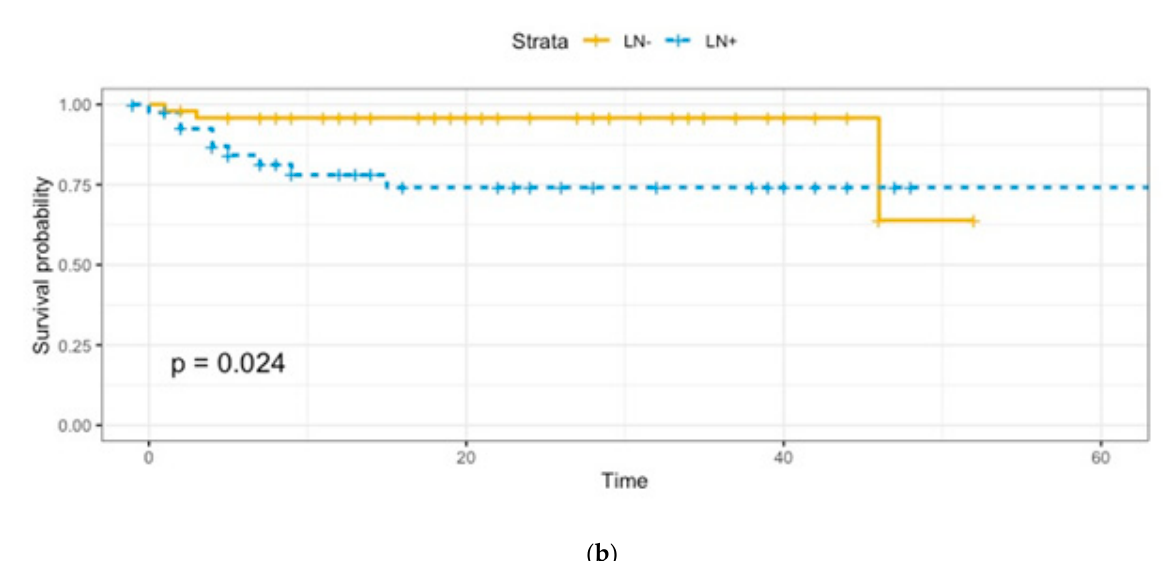
Figure 1. ( a ). Overall survival: Group A vs. Group B. ( b ). Disease-free survival: Group A vs. Group B.